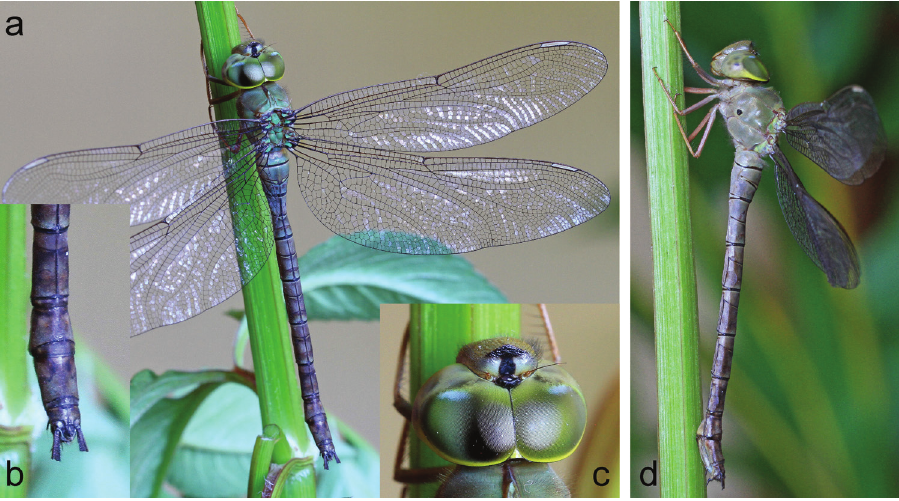
Figure 2. Gynacantha villosa , a female from Chingombe, Zambia: a a general dorsal view b distal seg- ments of abdomen with remaining proximal parts of cerci c head with a T-mark on the frons d a general lateral view (phot. B.